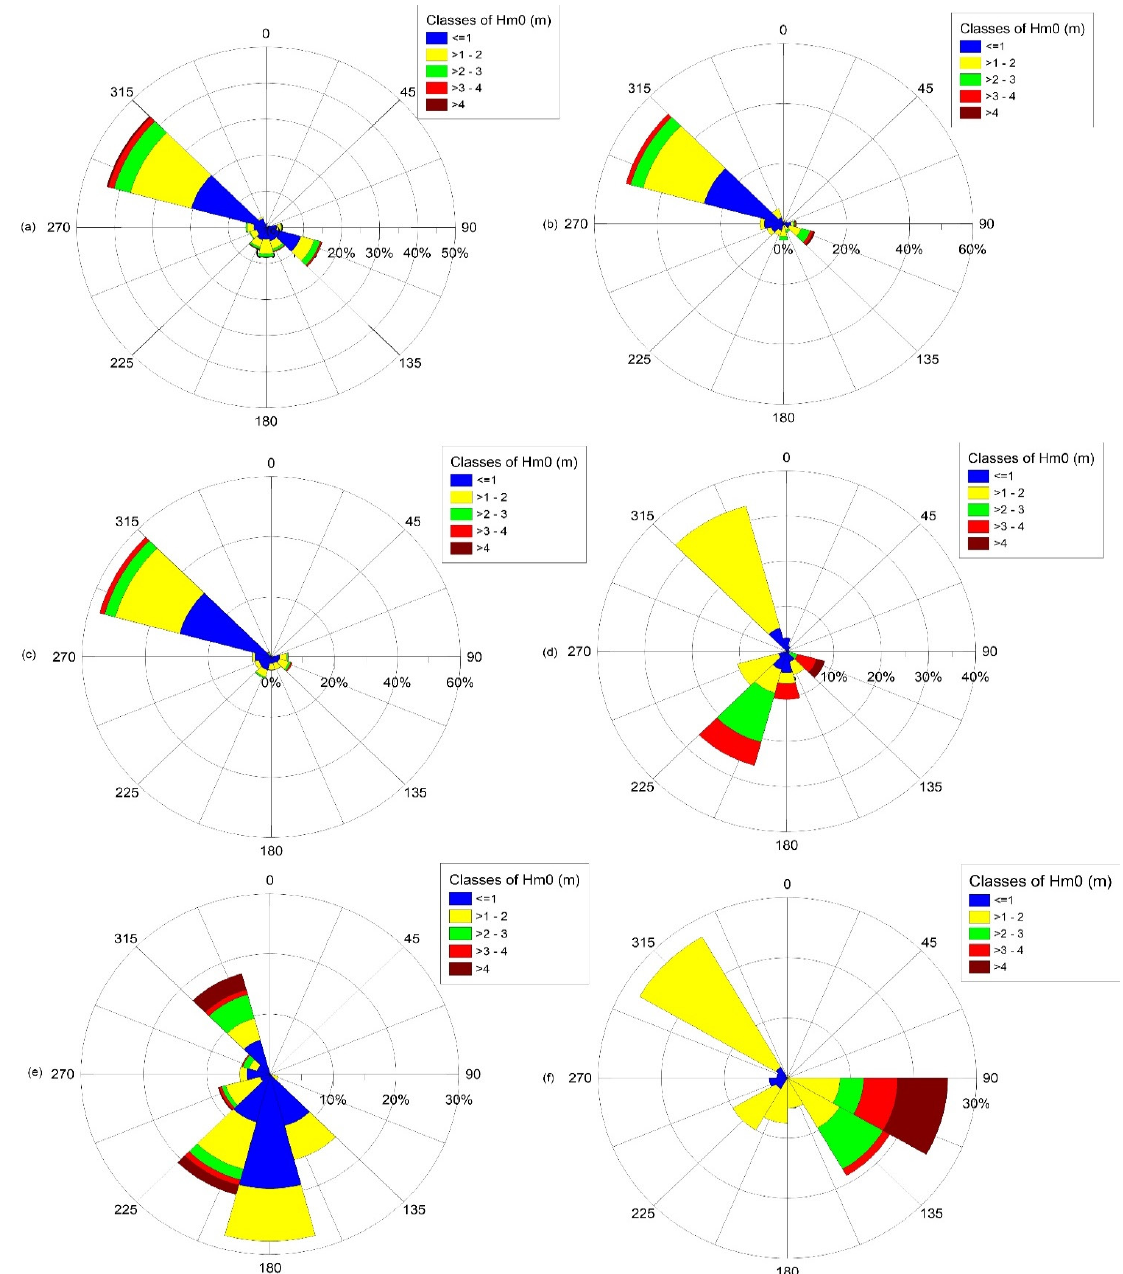
Figure 11. Rose diagram of offshore Hm0 corresponding to time periods of salient formation, i.e., ( a ) 1_sf, ( b ) 5_sf, ( c ) 9_sf, ( d ) 17_sf, ( e ) 21_sf, and ( f ) 29_sf (for symbols see Table 1). Figure created in Grapher 9.